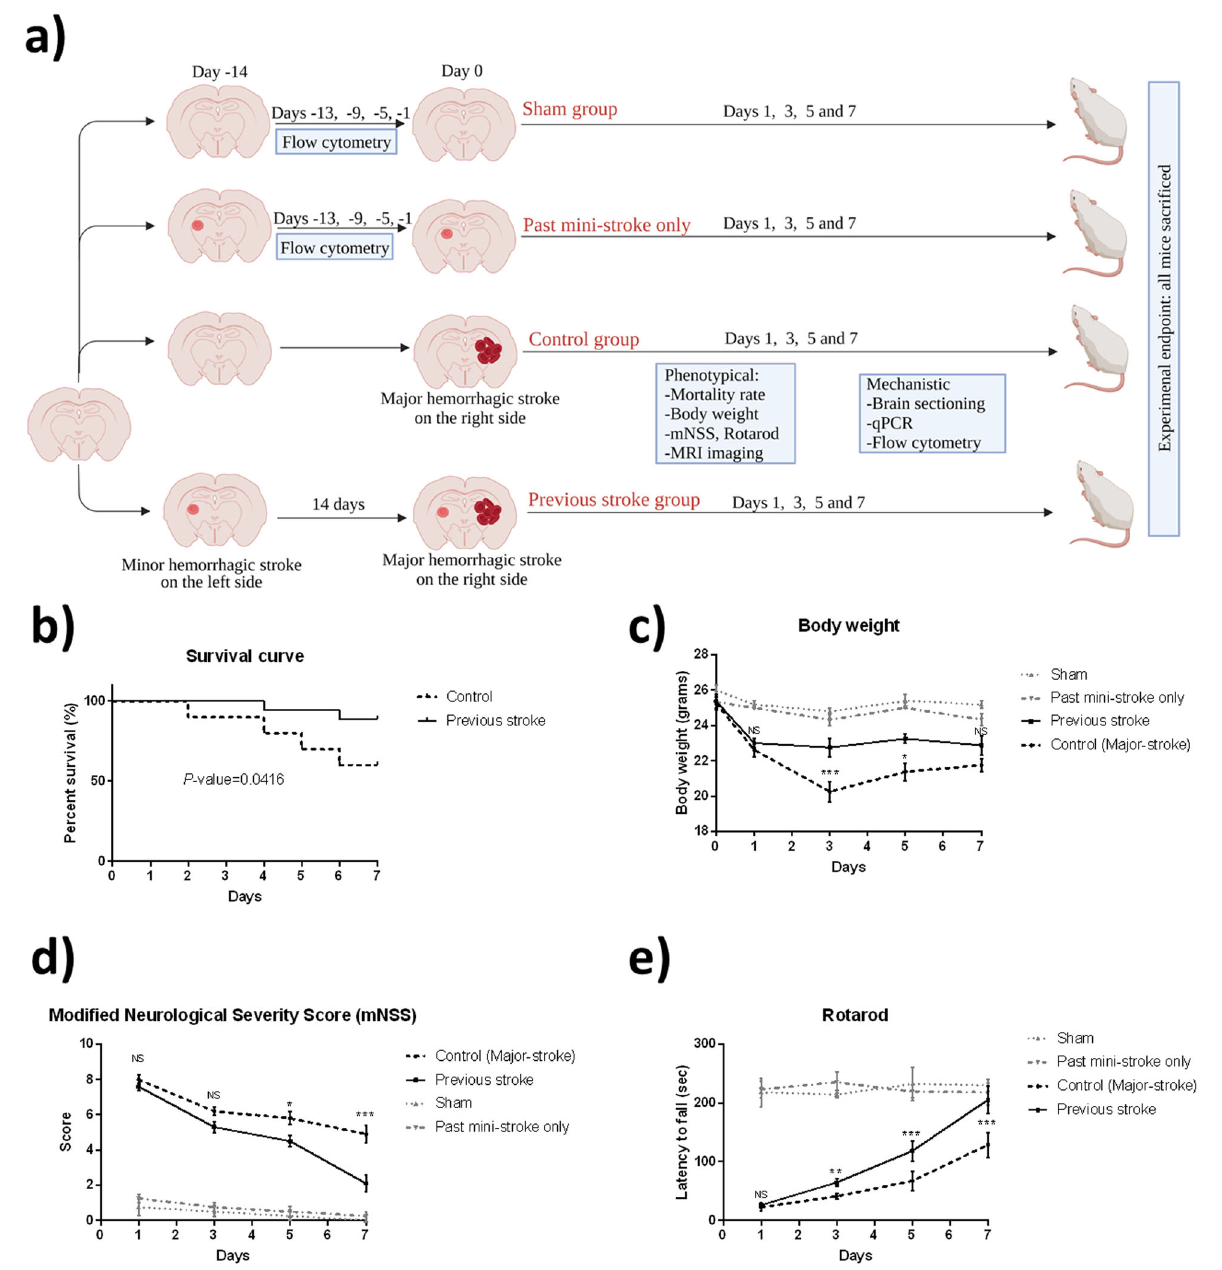
Fig. 1 Functional outcome measurements after a hemorrhagic stroke. a Sham group received two sham operations 14 days apart. Mice in the mini-stroke- only group received a minor stroke on day − 14. Mice in the control group received only one major HS on the right, whereas those in the “ previous stroke group ” received a minor HS on the left 14 days prior to a major hemorrhagic stroke on the right. Flow cytometry was conducted on days − 13, − 9, − 5, and − 1. Phenotypical and mechanistic parameters were measured on days 1, 3, 5, and 7. Behavioral tests were conducted on days 1, 3, 5, and 7 after a major hemorrhagic stroke at the right basal ganglia. b Survival curve of the previous stroke group and control group ( n = 25, Gehan – Breslow – Wilcoxon test, p = 0.0416). c Measurements of body weight ( n = 10, RM two-way ANOVA, p = 0.0183). d Modi fi ed neurological severity score assessment ( n = 10, RM two-way ANOVA, p = 0.0003). e Rotarod testing. Results presented as latency-to-fall (seconds) ( n = 10, RM two-way ANOVA, < 0.0001). Error bars indicate SEM. * p < 0.05, ** p < 0.01, NS not signi fi cant, mNSS modi fi ed Neurological Severity Score, MRI magnetic resonance imaging, qPCR quantitative polymerase chain